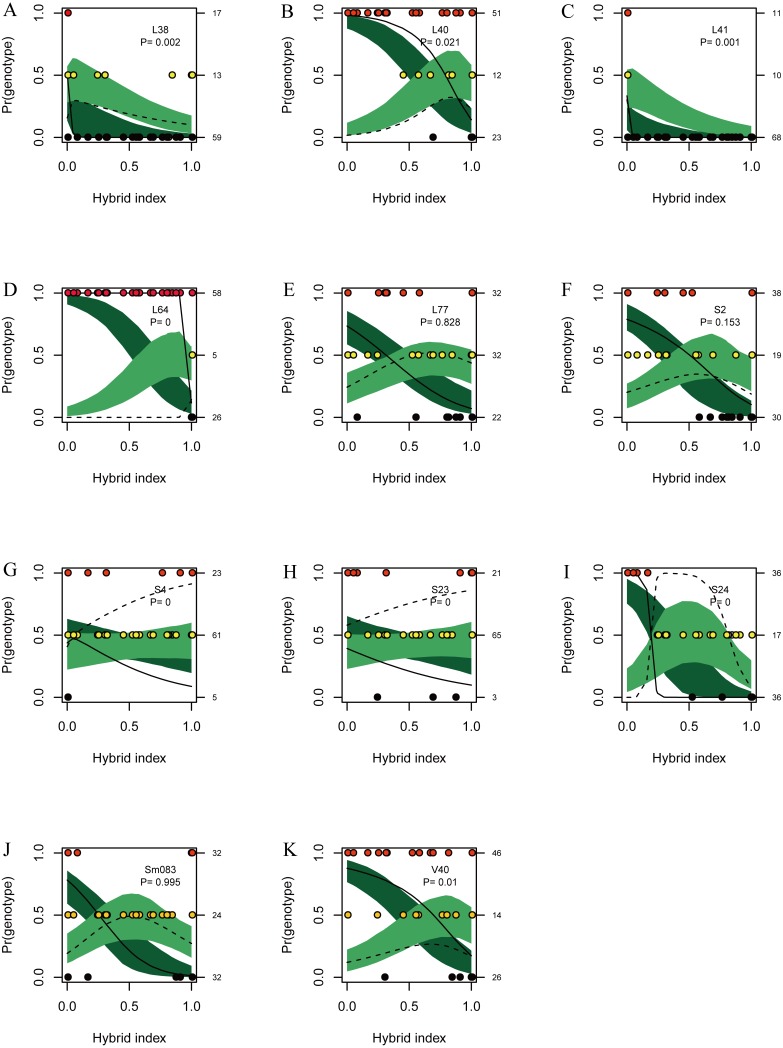
Genomic clines for nuclear 11 SSR loci (A–K) from hybrids between L. duciformis and L. paradoxa.The name of each locus is given, as is the P value (P < 0.021 indicates significance after FDR correction) for the test of departure from neutral expectations, on each panel. Solid and dashed clines represent the 95% confidence intervals for the expected homozygotes (Ad/Ad or Ap/Ap; dark green) and heterozygotes (Ad/Ap; light green) genomic clines given neutral introgression. The solid and dashed lines give the estimated clines based on the observed homozygotes and heterozygotes, respectively. Circles indicate the raw genotypic data (L. duciformis homozygotes (Ad/Ad): red, heterozygotes (Ad/Ap): yellow, and L. duciformis homozygotes (Ap/Ap): black), with counts of each on the vertical axis. The hybrid index quantifies the fraction of alleles derived from L. paradoxa across all 11 markers.